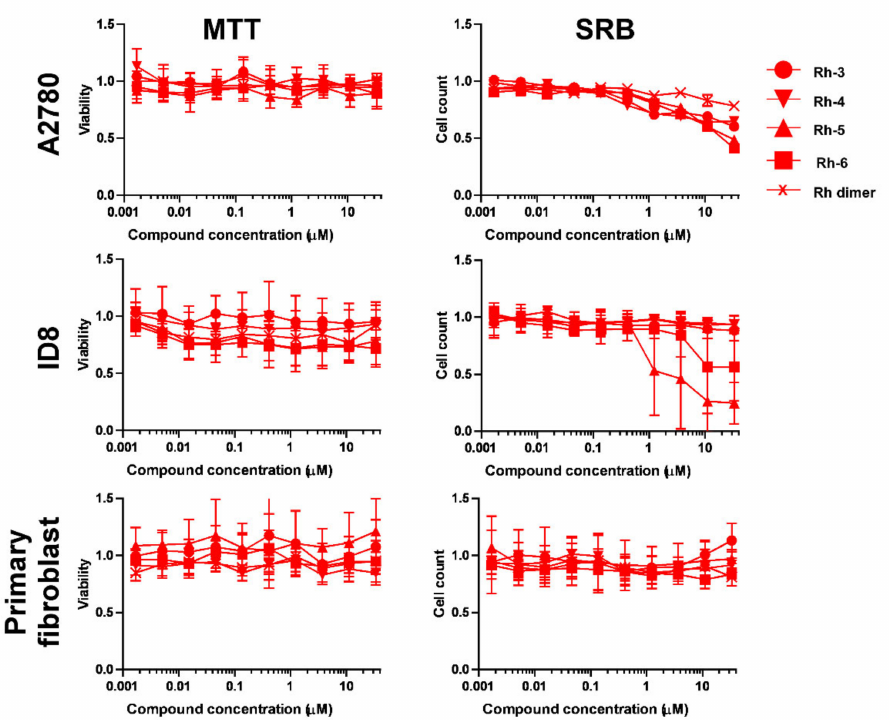
Figure 7. Assessment of rhodium complexes Rh-3-Rh-6 for cytotoxic and cytostatic activity. Briefly, 3 × 10 3 A2780 cells, 2 × 10 3 ID8 cells, and 4 × 10 3 primary fibroblasts were plated onto 96-well plates. Cells were treated with the compounds in the concentrations indicated for either 4 h for an MTT assay or for 48 h for an SRB assay. Data are represented as average ± SD, from three biological replicates; individual assays were performed in duplicate. Values were normalized for vehicle-treated cells; absorbance for vehicle-treated cells is equal to 1. A one-way ANOVA, followed by a Kruskal–Wallis test, was performed individually for each compound. The results of the statistical analysis are presented in an Excel spreadsheet at https://figshare.com/s/28d14597d5041f08eb08 (accessed on 6 January 2022). Nonlinear regression was performed on the